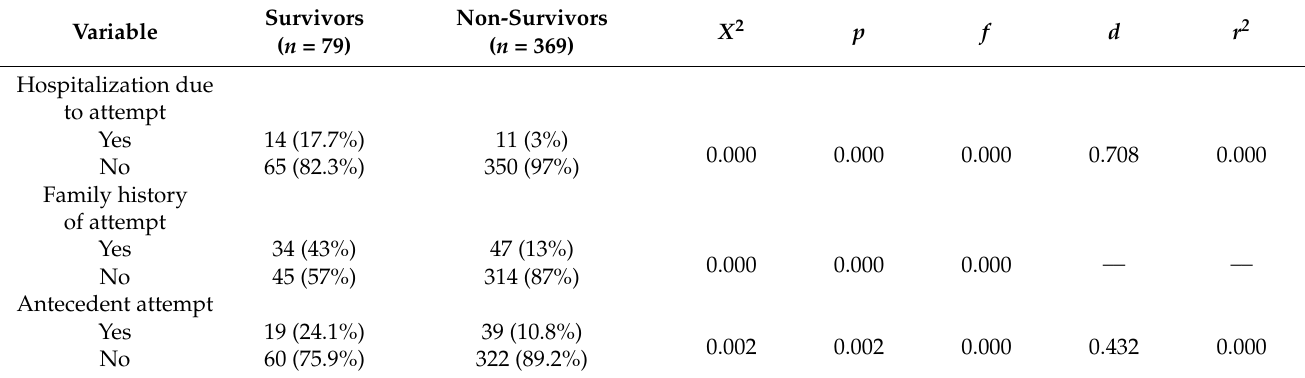
Table 2. Adolescent risk factors as a function of survivor status.